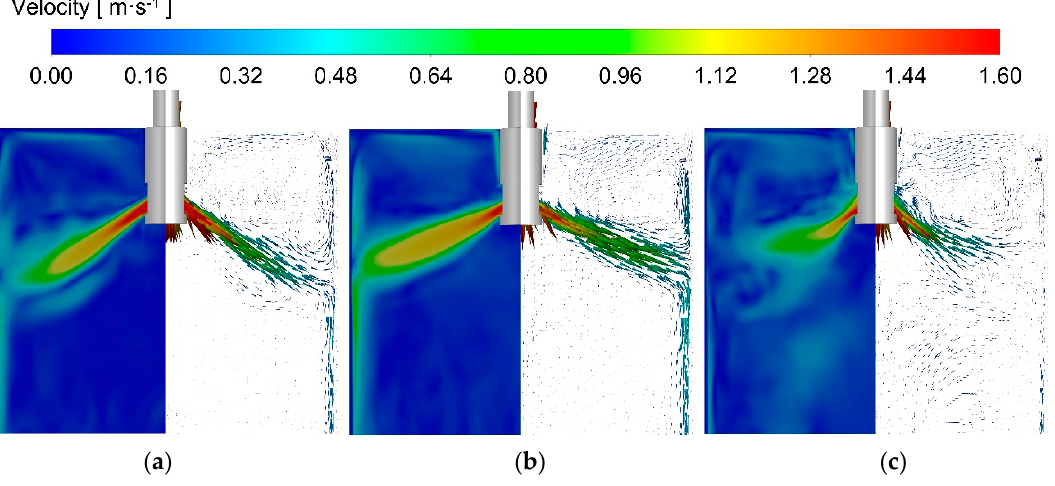
Figure 7. Contour and vector diagram of velocities in mold under EMBr Mode 3 and at different argon flow rates of: ( a ) 0 L·min − 1 , ( b ) 6 L·min − 1 , ( c ) 10 L·min − 1.